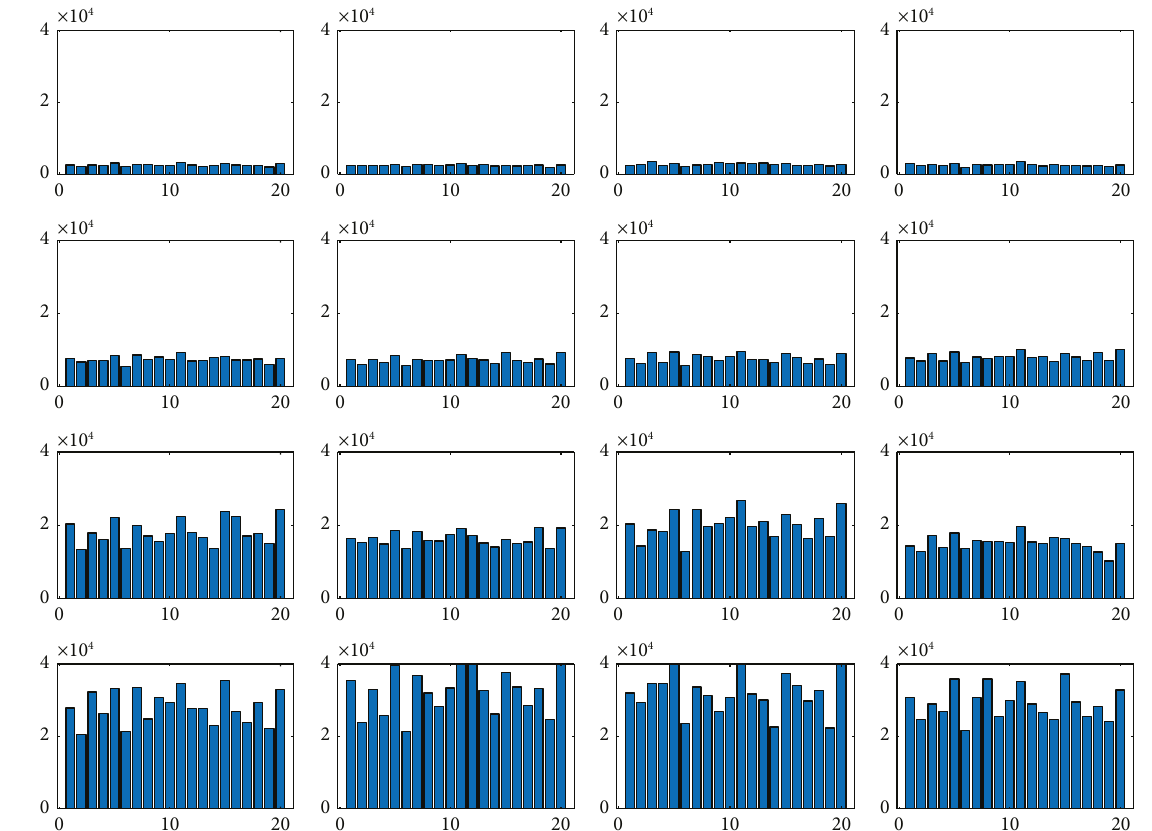
Figure 8: Feature matrix calculated by NMF at r �